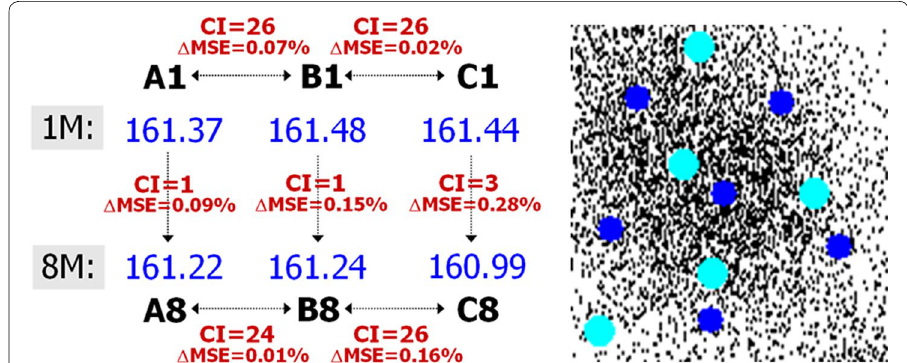
Fig. 9 With image dataset Bridge ( k (10%) but difference in SSE is negligible (< 0.2%). Visualization (right) shows the difference in